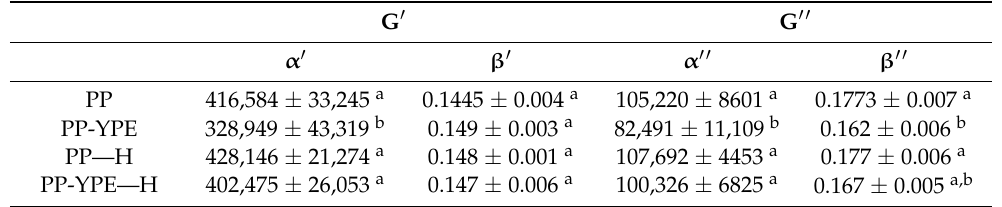
Table 3. Frequency dependence of G ′ and G ′′ described by the power-law equations for pear pomace (PP), pear pomace enriched with YPE (10% w/w ) (PP-YPE), heated pear pomace (PP-H) and heated pear pomace enriched with YPE (10% w / w ) (PP-YPE-H). For each parameter samples with different letters are statistically different ( p < 0.05). 0.9989 < R 2 > 0.91.